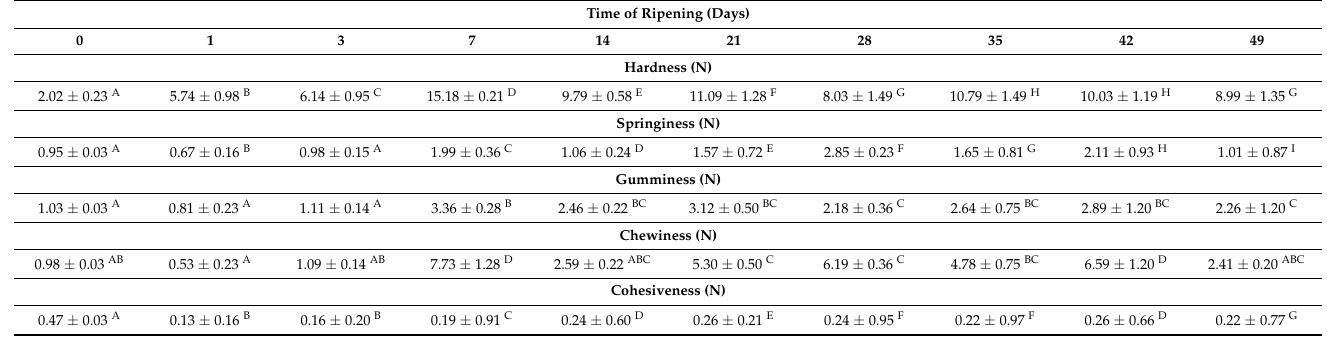
Table 2. The effects of evaluation of the textural changes during the ripening